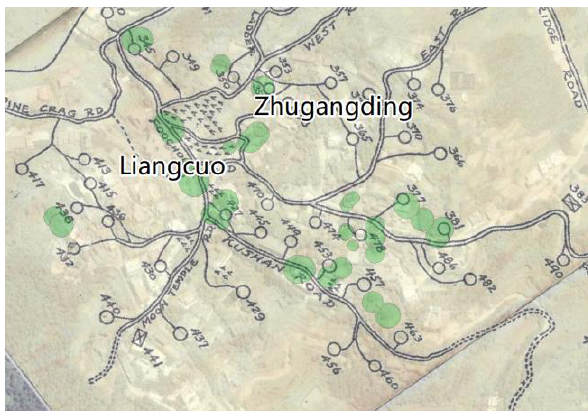
Figure 8 The existing Cryptomeria trees were marked by their crown diameters on the map, showing the relationship between the trees and the